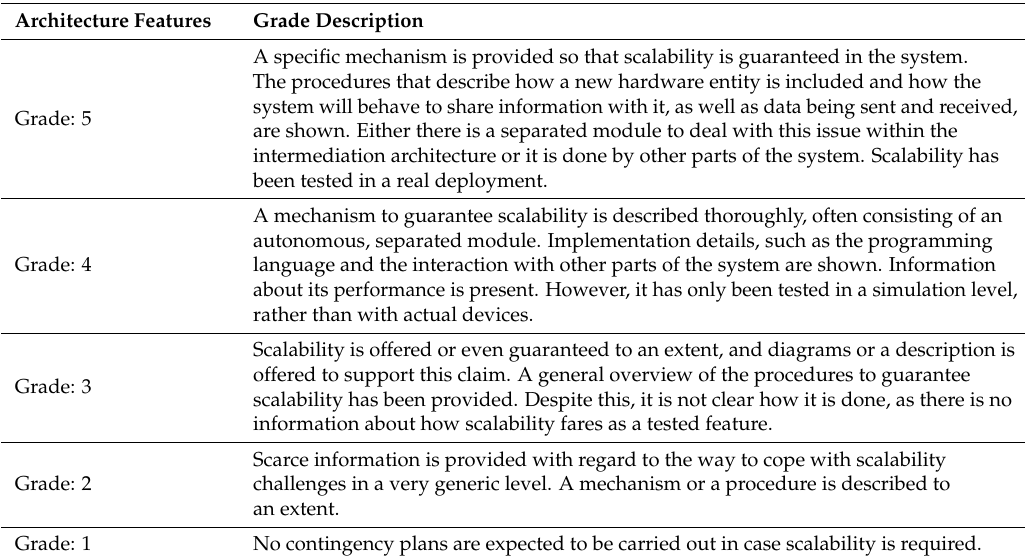
Table 6. Scalability assessment.